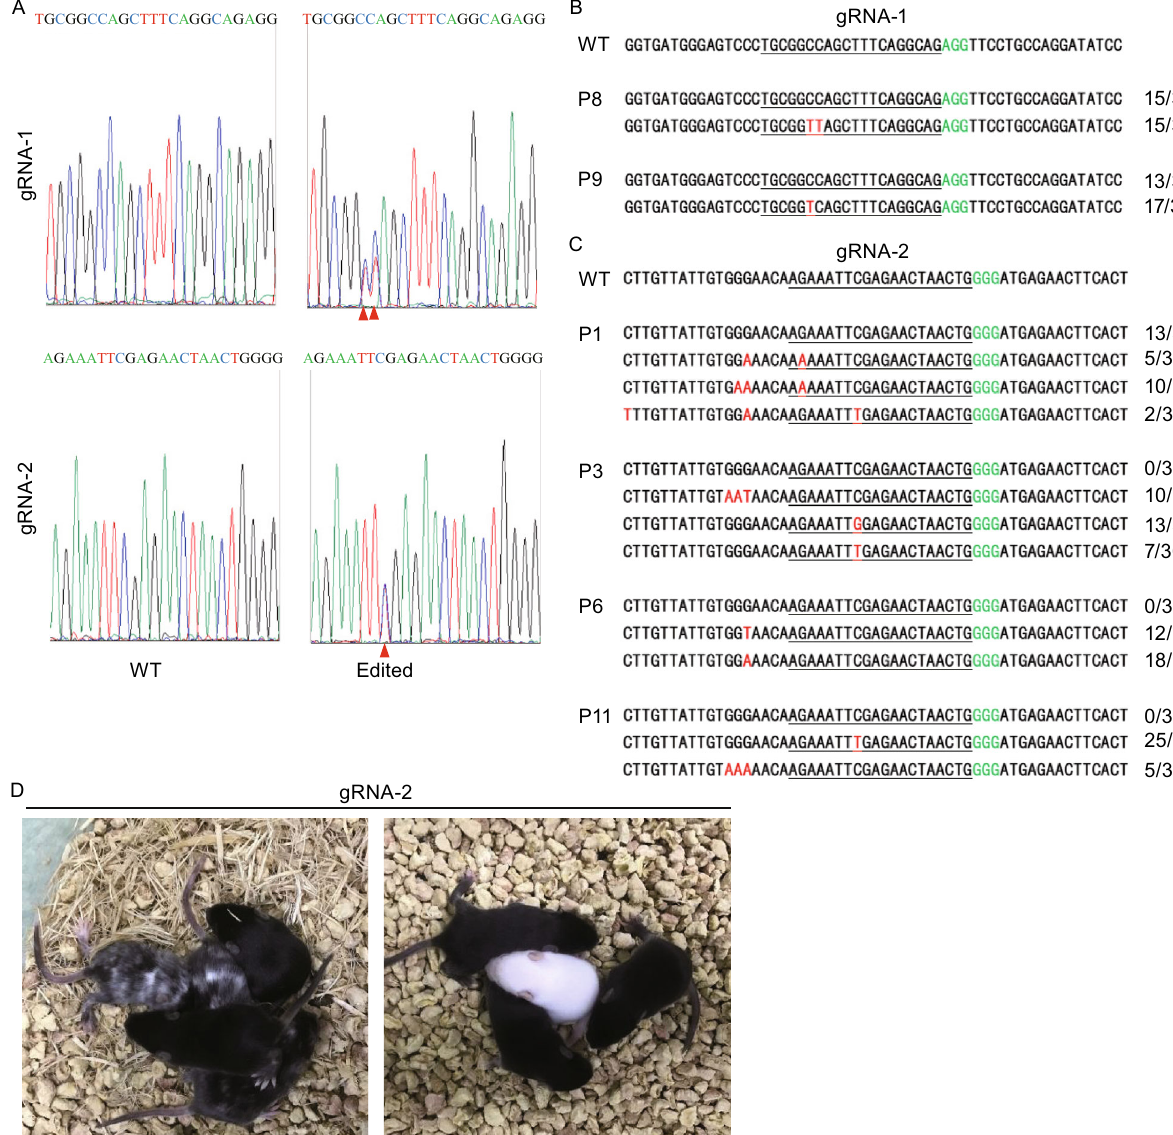
being critical for the activity and function of tyrosinase (Fig. 3C). When the biallelic mutant P11 pup was mated with WT mouse, we found that the mutant allele could be suc- cessfully transmitted to the next generation (Fig. S6).